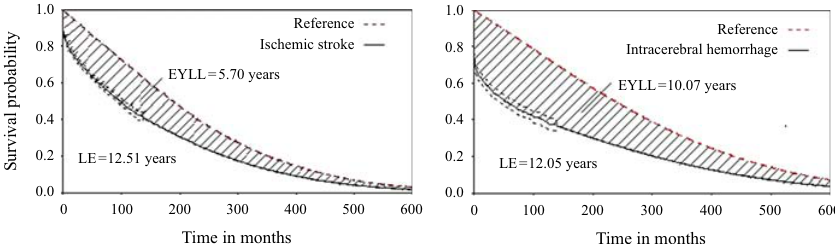
600Reference Reference